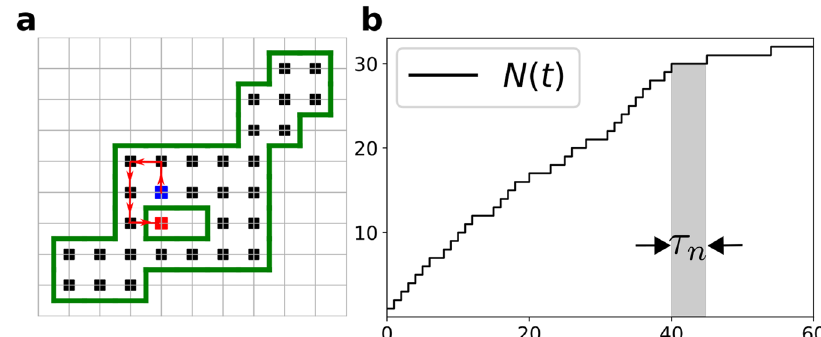
Fig. 1 | De fi nition of the random variable τ n . a A visited domain (black sites) and trajectory. b The time intervals τ n between increments in N ( t ), the number of new itsboundary(greenline)foraRWonthesquarelattice.The n th and( n +1) st newsites sites visited at time t visited are blue and red squares. The red links indicate the intervening RW (cid:1) (cid:3) (see Sec. S1 in the Supplementary Table 1. (v) The algebraic decay of F n ( τ ) in the recurrent case should be scaling form F n ð τ Þ = n (cid:2) 3 ψ τ = n 2 compared with the simpler problem of a recurrent RW in unbounded space, where the fi rst-passage time distribution to a given target behaves at large times like F target ( τ ) ∝ 1/ τ 1+ θ , with θ the so-called per- sistence exponent 46 . Because θ =1 − μ for processes with stationary increments 38 , and in particular for Markovian processes, the algebraic decay of F n in Table 1 can be rewritten as F n ( τ ) ∝ τ − (2 − θ ) , insharpcontrast with the decay of F target ( τ ). While the two exponents coincide for a simple RW in 1 d (for which θ =1/2), the problem here involves the fi rst-